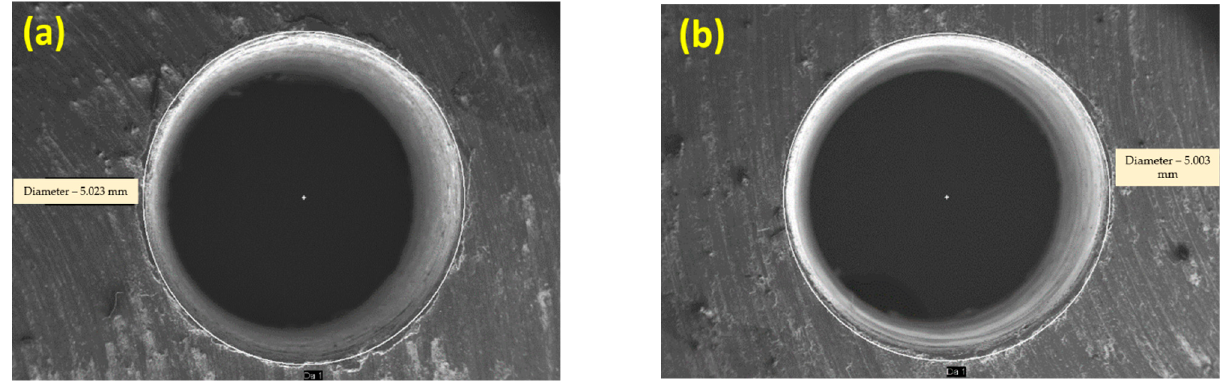
Figure 6. ( a ) SEM image of overcut initial conditions; ( b ) optimal conditions.